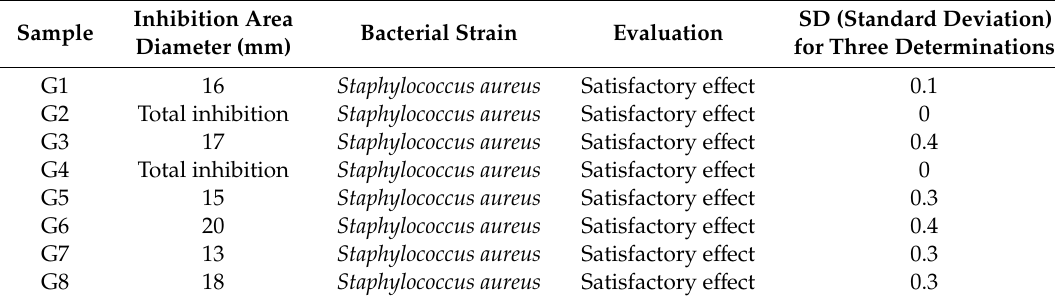
Table 3. Evaluation of the antimicrobial activity of the microcapsules.